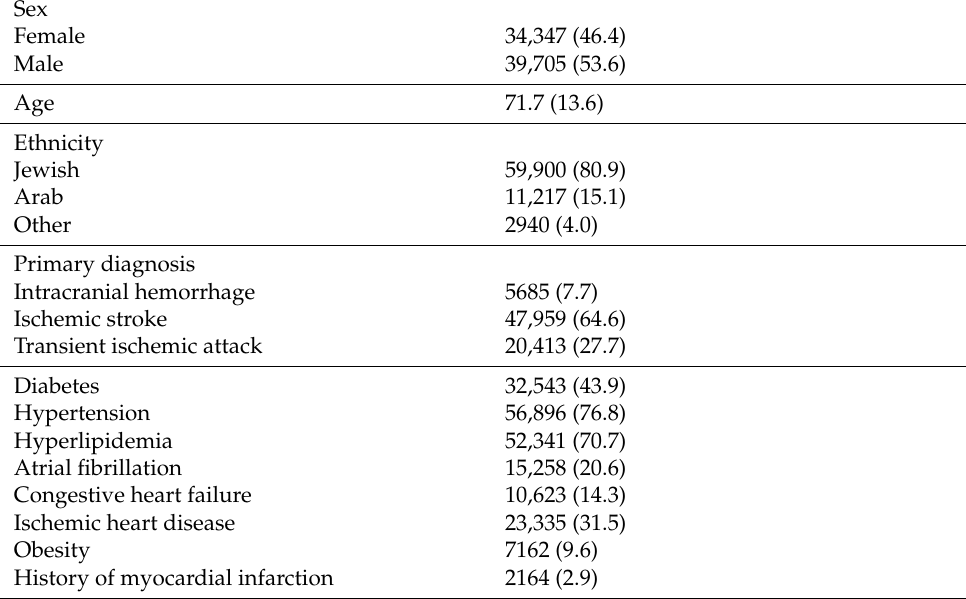
Table 1. Population characteristics (N = 74,052).